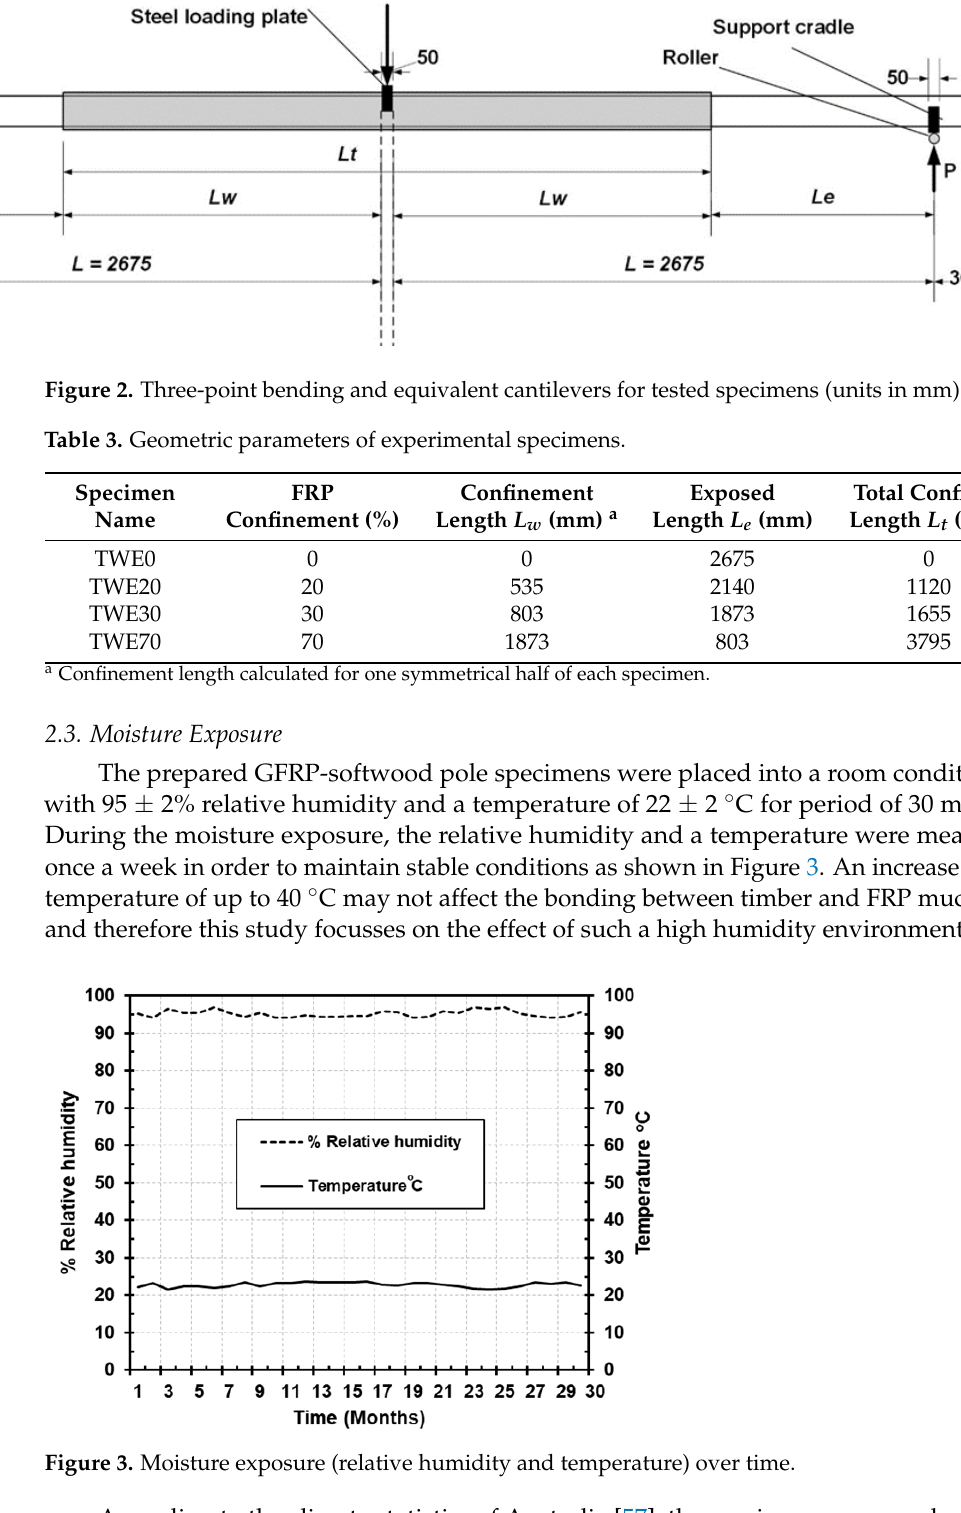
Table 3. Geometric parameters of experimental specimens.